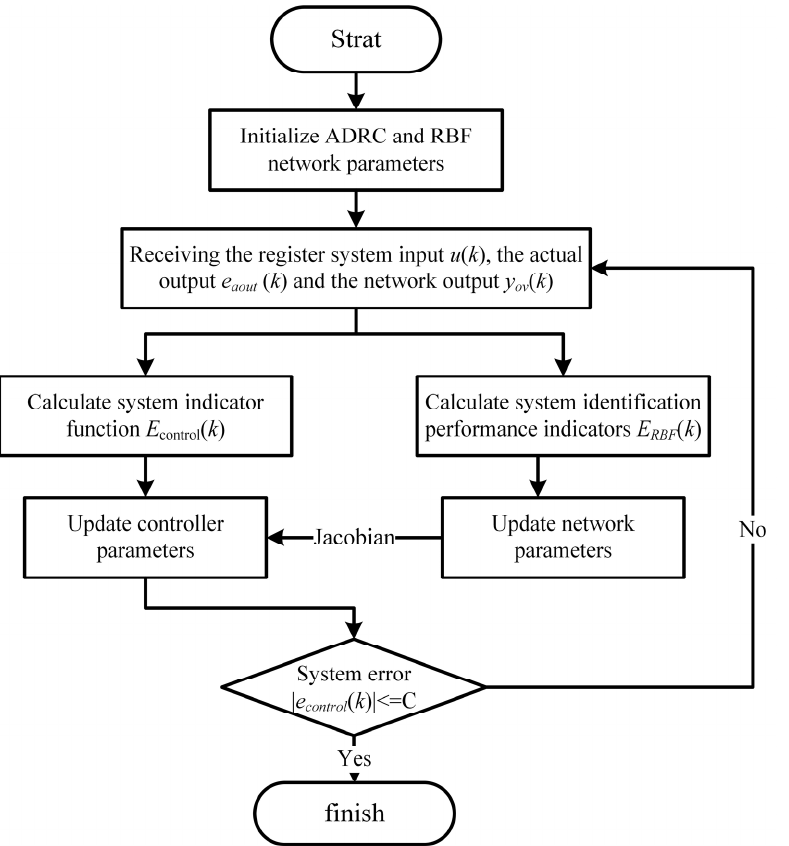
Figure 7. The process of controller parameters adjustment.